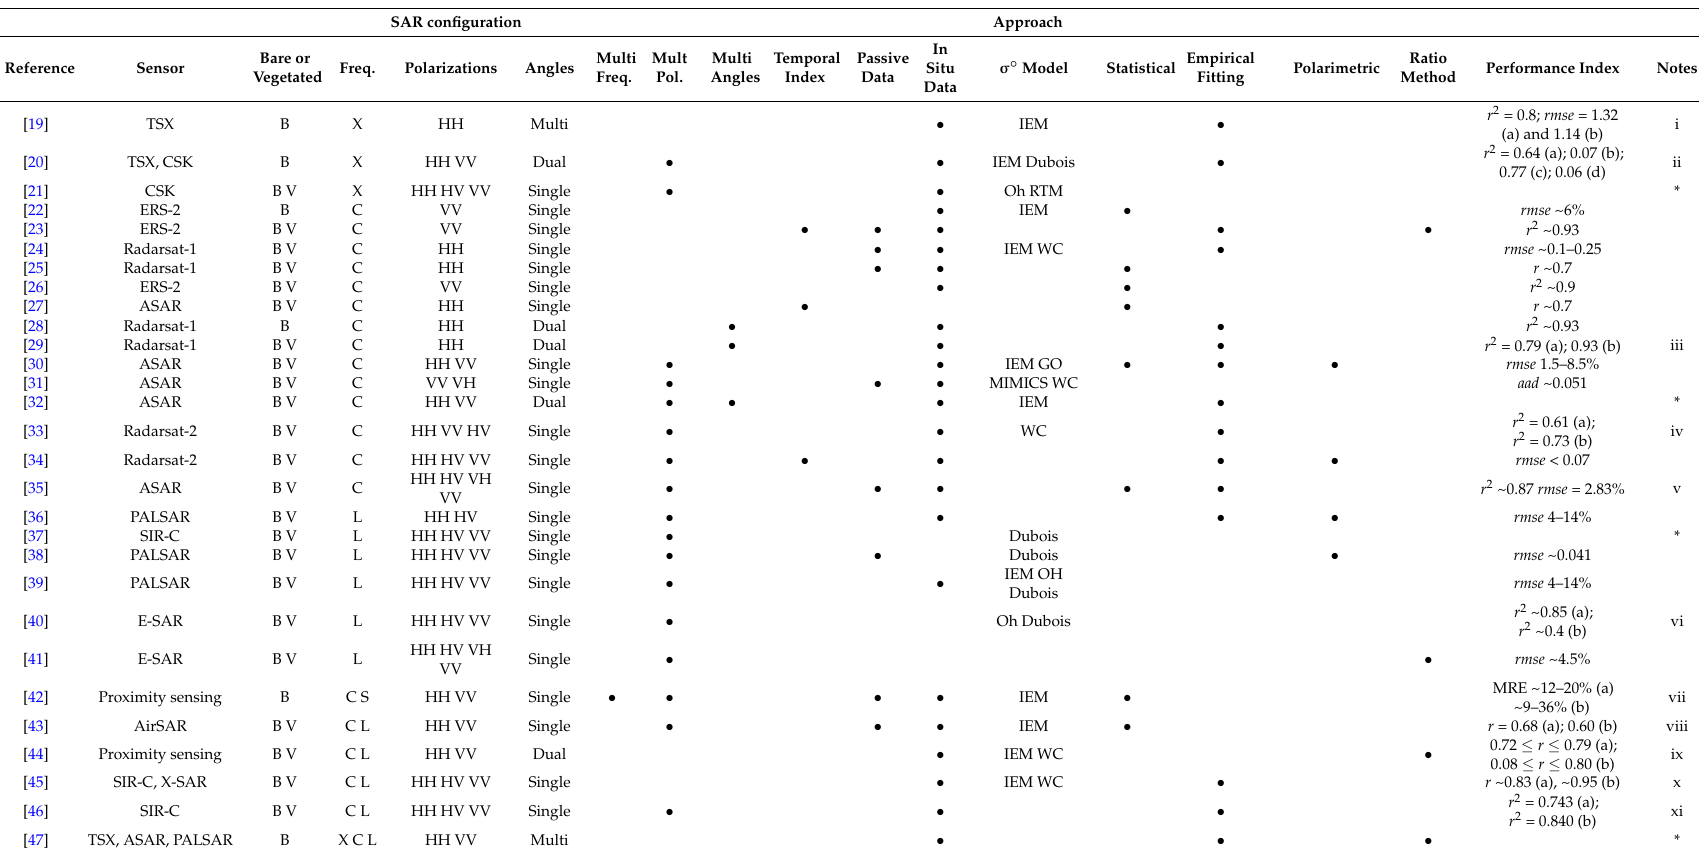
Table 1. m v retrieval using SAR: overview table on previous studies. Accuracy is reported in terms of: determination coefficient, r 2 ; correlation, r ; root mean square error, rmse ; average absolute deviation, aad ; and mean square error, mse . For detailed notes please refer to Appendix